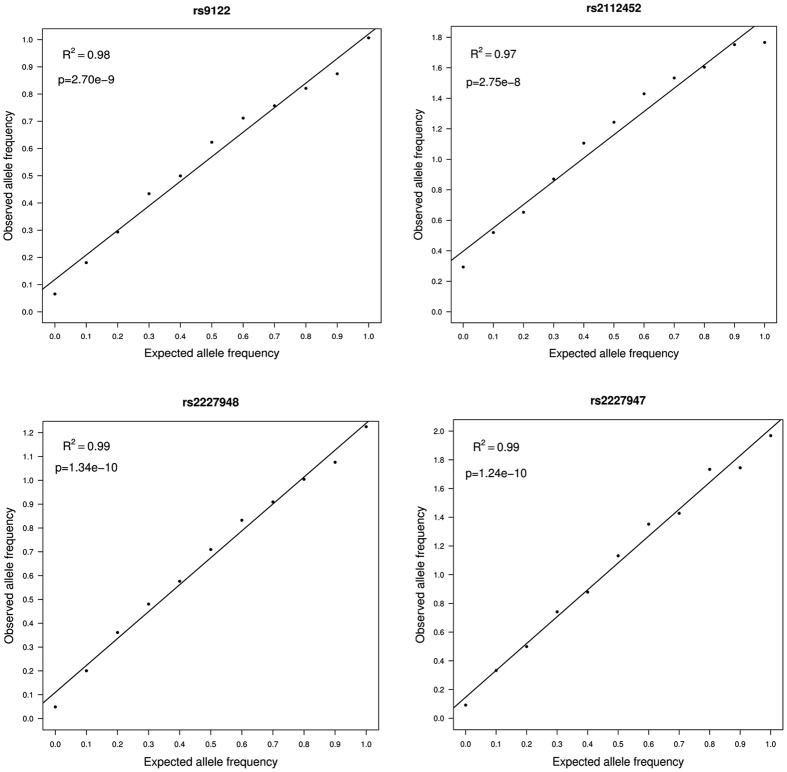
Evaluation of MassArray as a quantitative technique for allele-specific expression.For each SNP of the MCC gene, the two homozygous genomic DNAs as to the different alleles were mixed at known ratios (i.e. expected allele ratios). Observed allele ratios were obtained by the MassArray analysis of amplification products on each mixture. Pearson’s correlation test was involved in a further analysis.